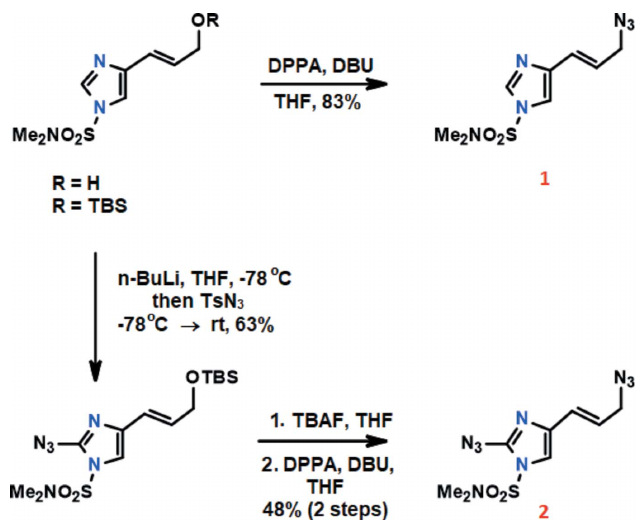
Figure 7 Synthetic scheme for both compounds. The title compounds are highlighted in